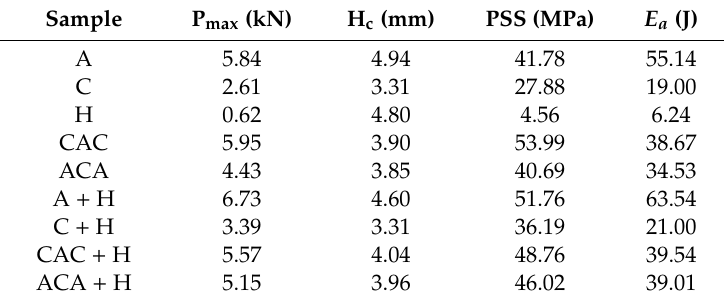
Table 3. Comparison of QSPT results.